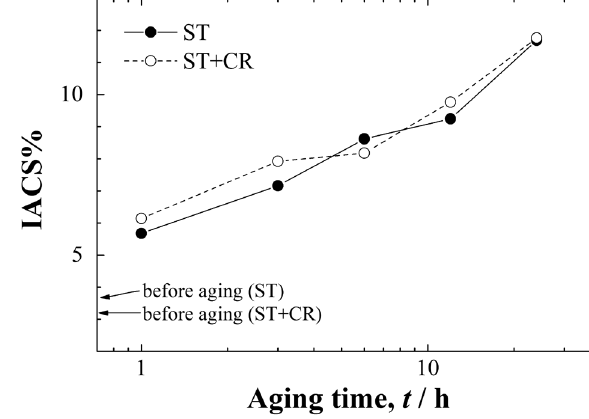
Fig. 8: Variations in the radii of precipitates of ST and ST + CR specimens with aging at 723 K.